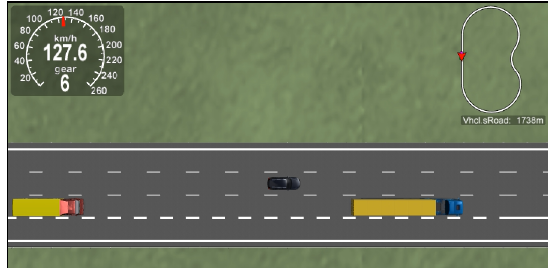
Figure 4. Snapshot of the scenario, including two commercial vehicles.